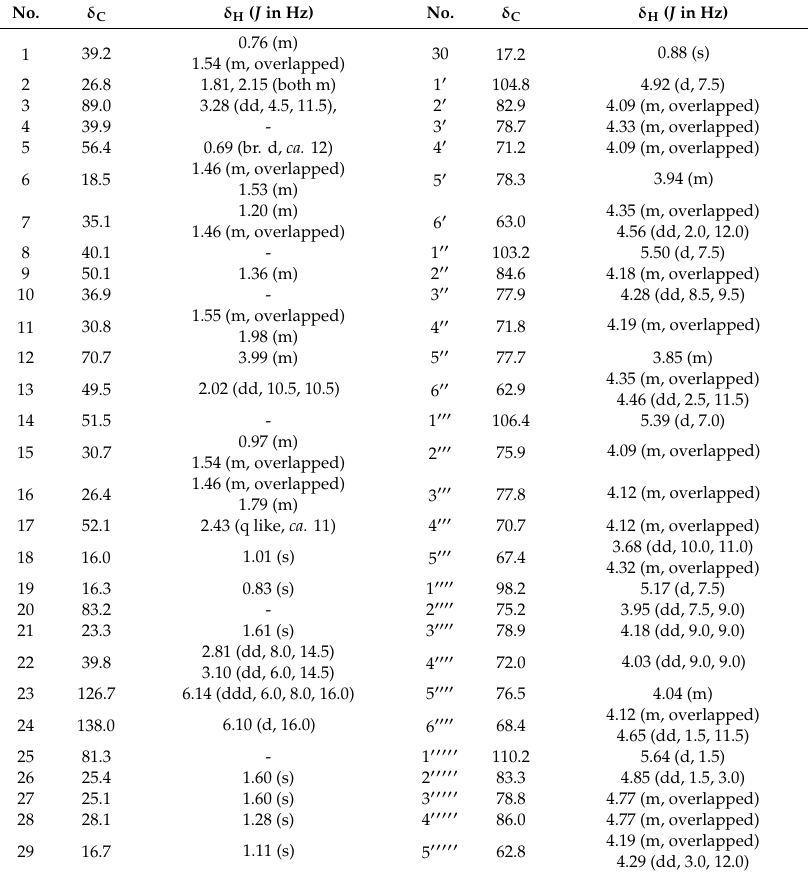
Table 3. The 1 H and 13 C-NMR data for 3 in C 5 D 5